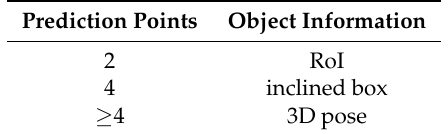
Table 1. Correspondence between predicted points and available object information [17,23].